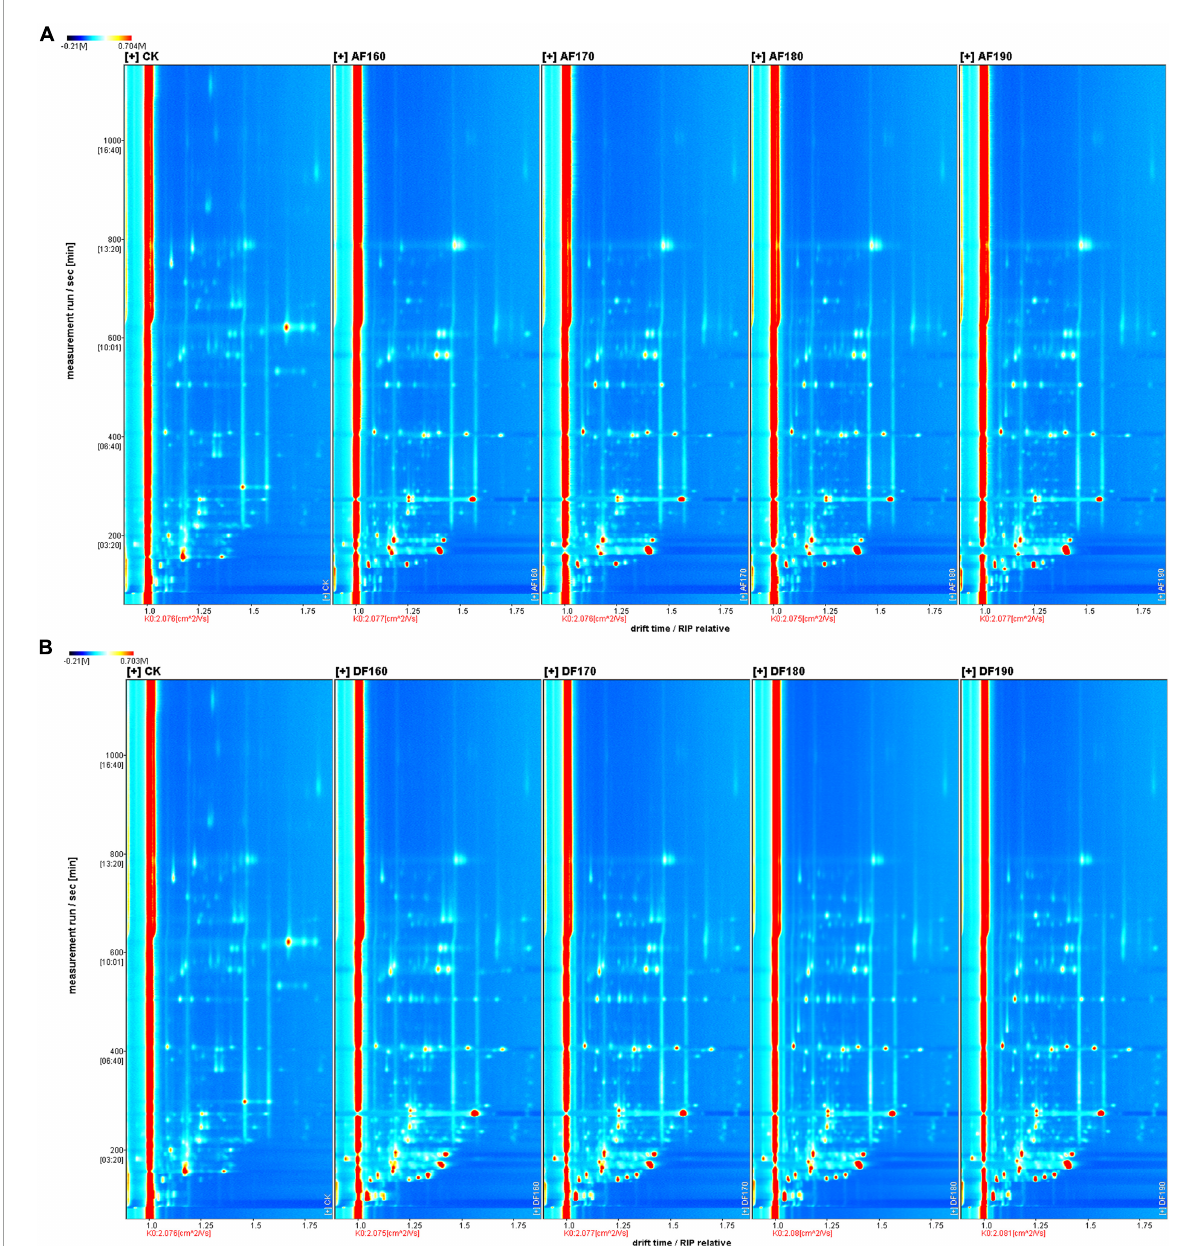
FIGURE3 Effect of frying temperature on the gas-phase ion mobility spectrum (GC-IMS) of AFSM (A) and the GC-IMS of DFSM (B) . DF, shrimp meat was treated with deep frying; AF, shrimp meat was treated with air frying; 160, 170, 180, 190: The fried temperature of shrimp meat is expressed as 160, 170, 180, and 190 ◦